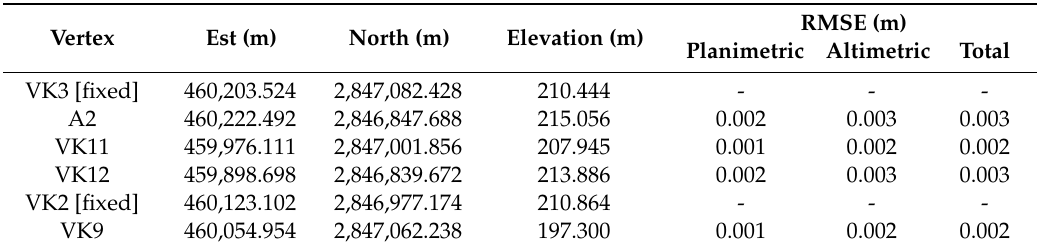
Figure 1. The Valley of Kings (VOK) in Luxor: ( a ) VOK location in UTM (source Google Earth). ( b ) The measured topographic network (red triangles) and the localization of Ground Control Points (black and white markers) derived from total station measurements, superimposed to the Sheet 1/70, KV and WV extracted from the Atlas of the Theban Mapping Project (TMP), page 13, Plan 1:2500, Contour interval 10 m. Table 2. Coordinates of topographical vertcies characterized by the accuracies shown in the last three columns on the